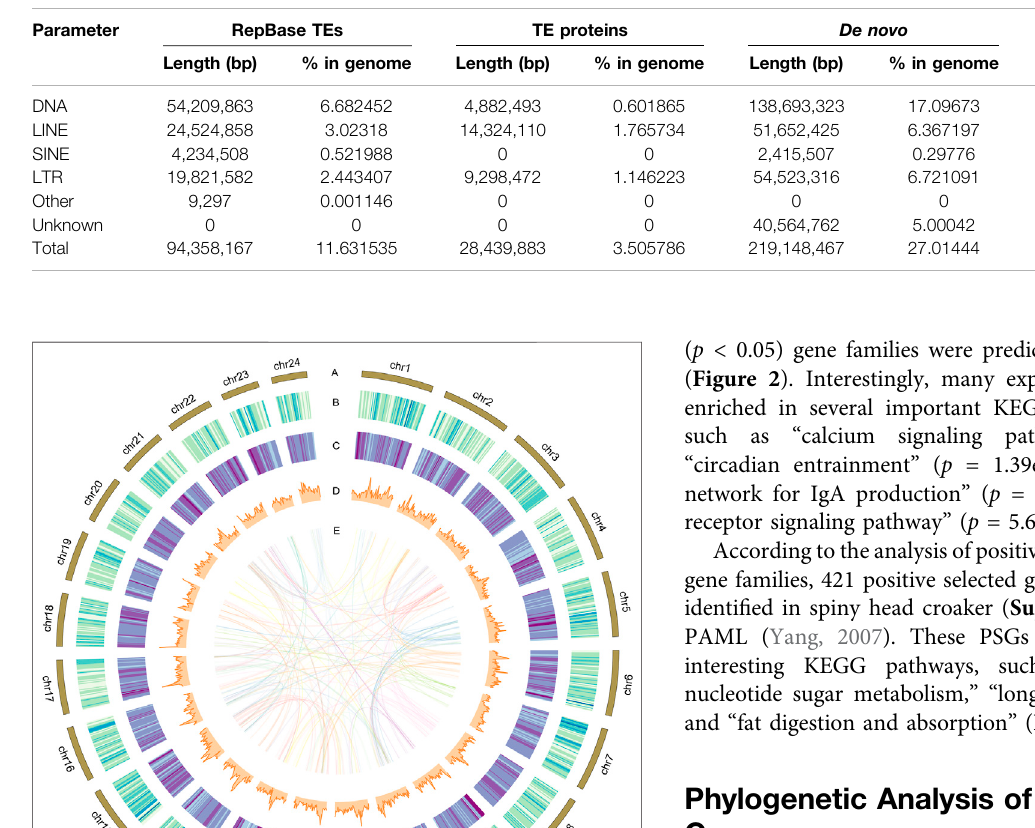
TABLE 2 | Repetitive elements in the assembled genome of spiny head croaker.